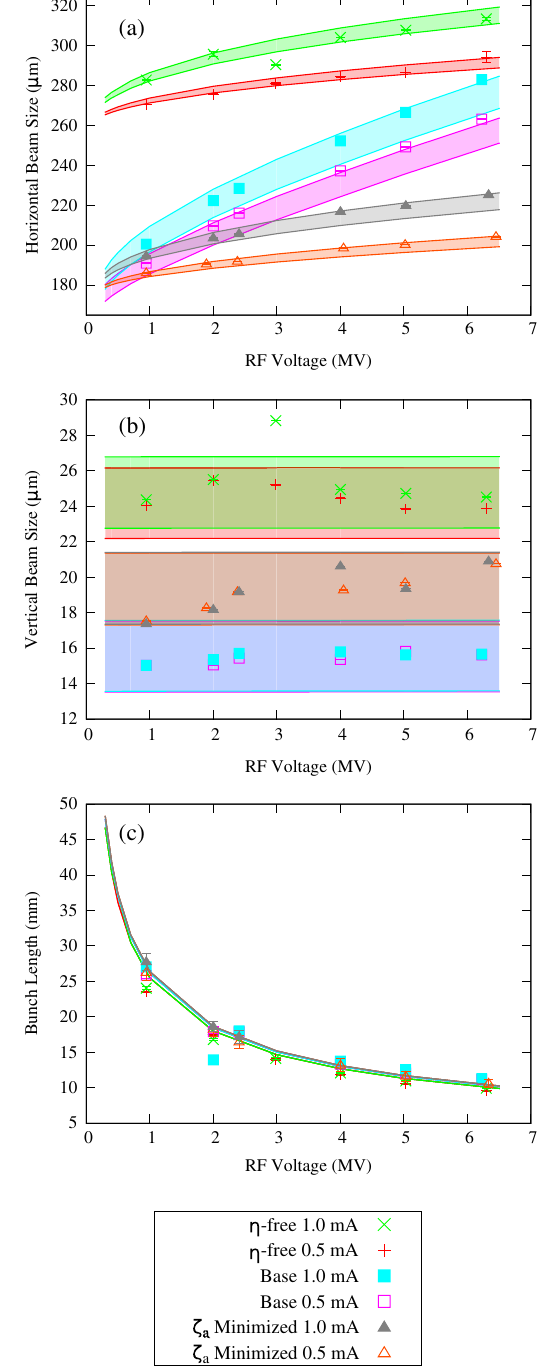
FIG. 5. (a) Horizontal, (b) vertical, and (c) bunch length measurements and simulation results. Points are data and curves are simulation results. The data points are the average over several measurements and the error bars are the statistical uncertainty. In CesrTA, 1 . 0 mA ¼ 1 . 6 × 10 10 particles =